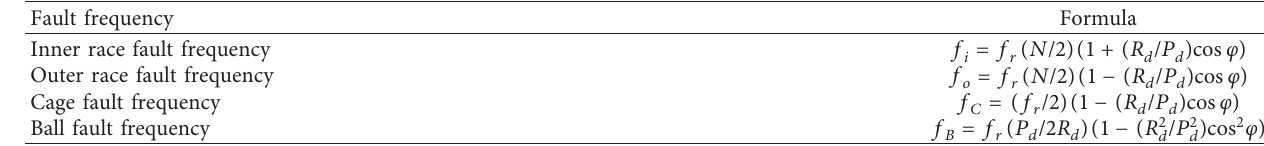
Table 4: Mathematical equations of bearing fault frequencies.